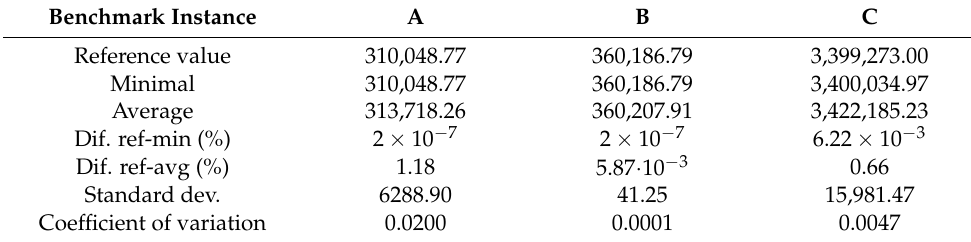
Table 10. Calculations